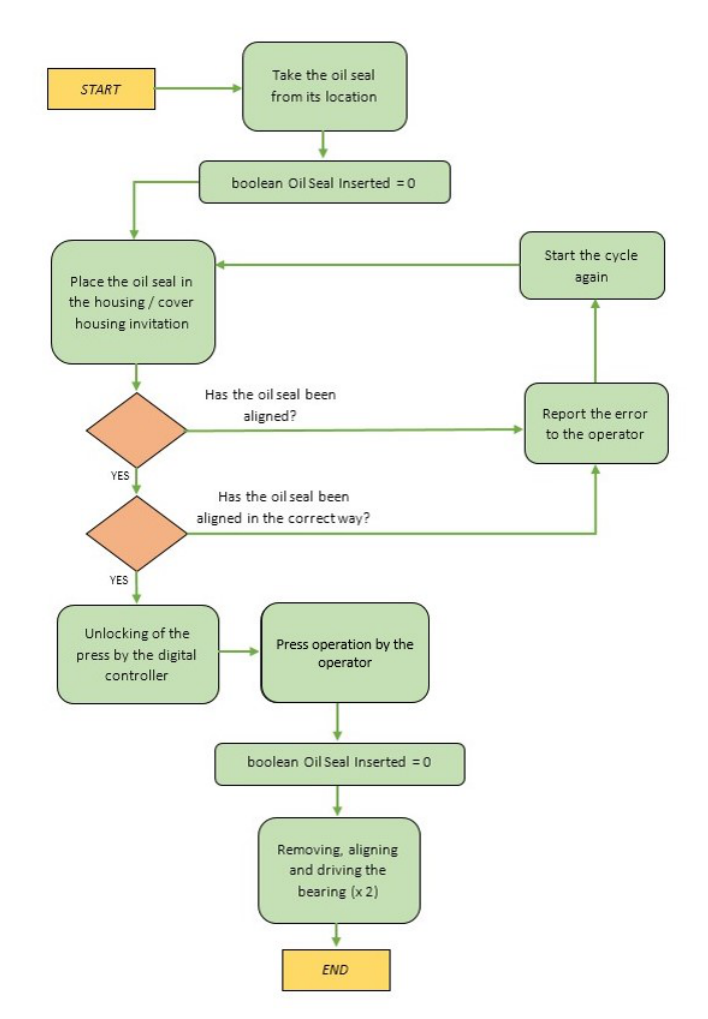
Figure 18. Operational flow